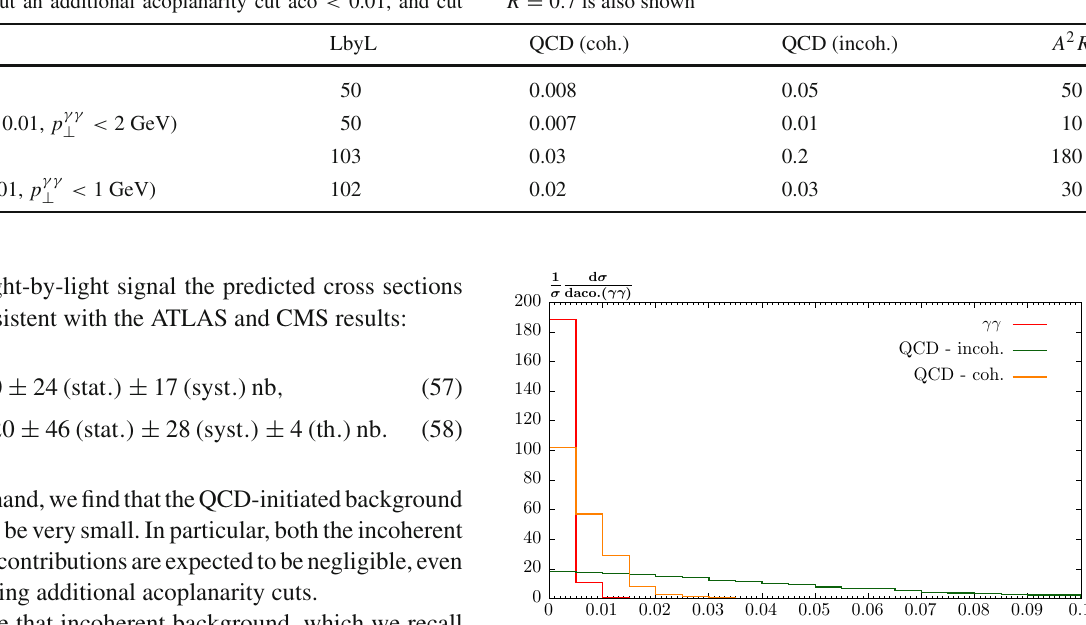
γγ < 1 (2) GeV in the CMS ⊥